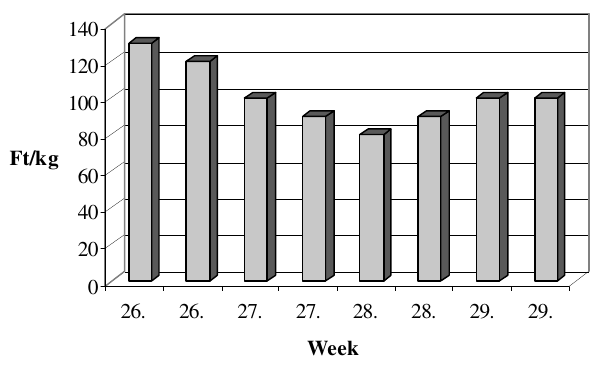
Figure 2: Changes of producer’s prices paid by the processing industry in 2006 during the season (in half weekly intervals)